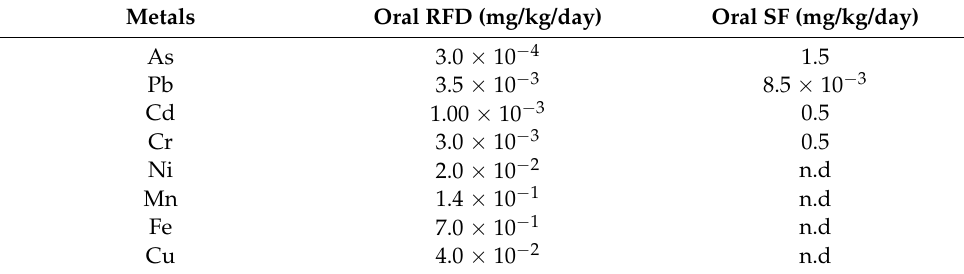
Table 1. Showing the exposure values.